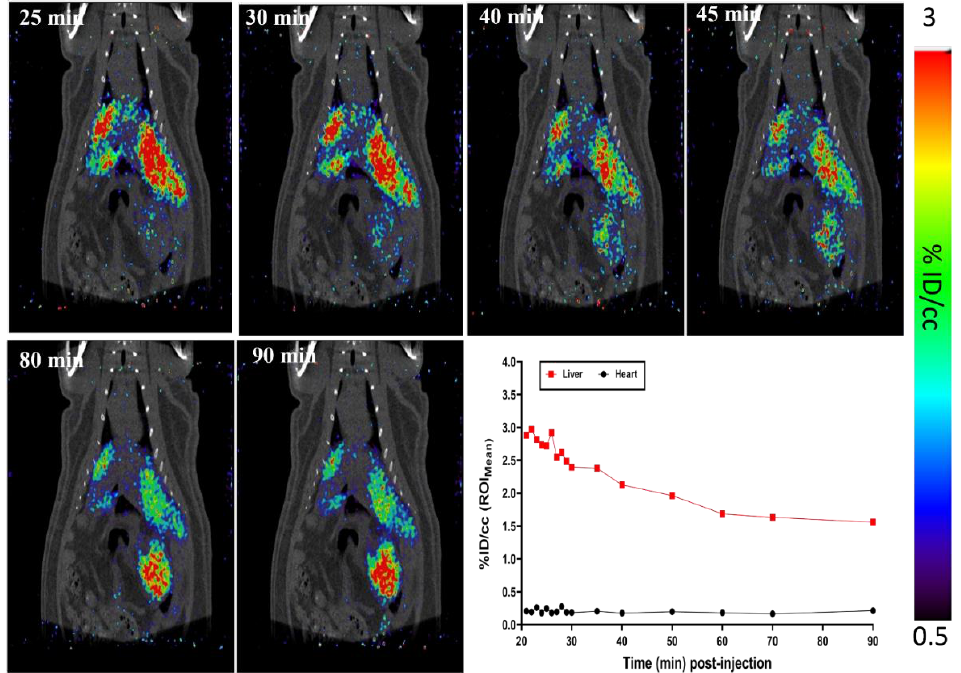
Figure 3. MicroPET imaging of I.A. administered [ 124 I]I-UC-MSC-EVs in male rats. The representative MRP PET/CT serial images were taken ( top and left bottom ) at 25 min, 30 min, 40 min, 45 min, 80 min, and 90 min post-injection. Tissue time-activity curve of the liver and heart were also shown ( right bottom ).